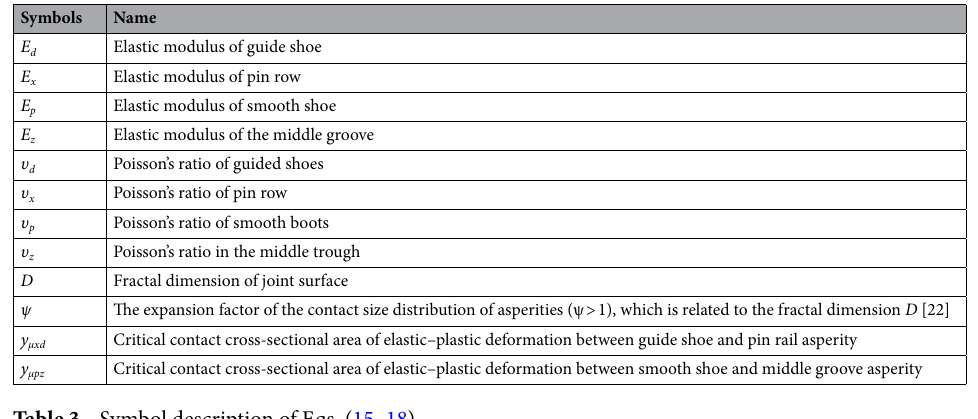
Table 3. Symbol description of Eqs.